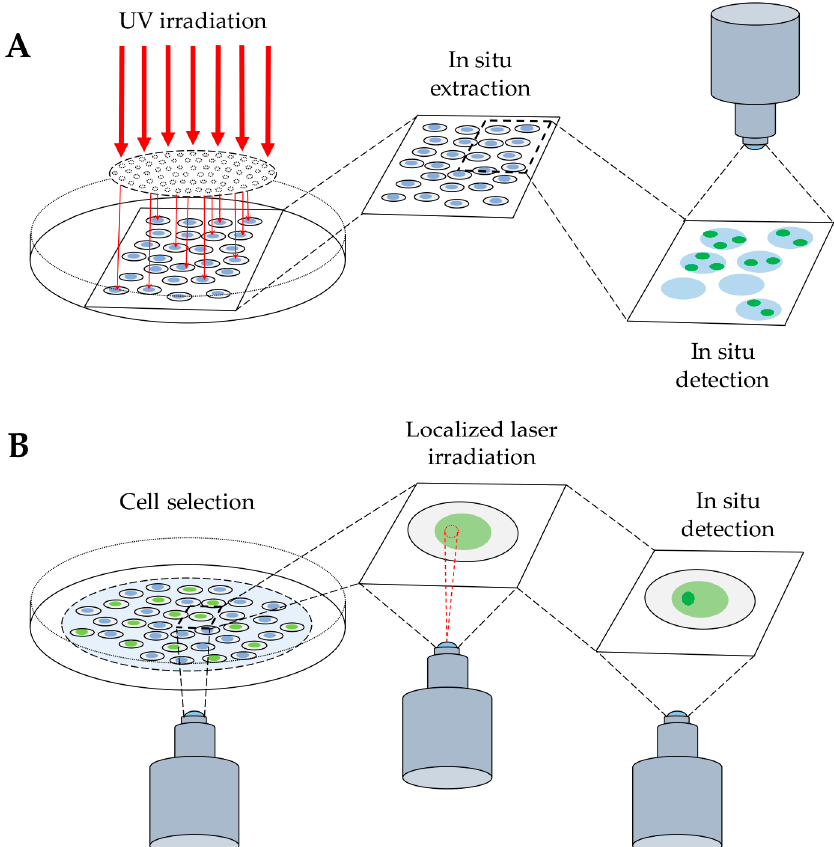
Figure 1. Detection of protein binding to DNA after radiation-induced DNA damage. ( A ) Schematic representation of cell exposure to UV radiation through a micropore polycarbonate filter to produce local DNA damage (see section 2.1.1). The next step of in situ extraction allows the release of unbound molecules, enabling the final detection of protein bound to DNA, by immunofluorescence technique. ( B ) Cell exposure to local laser irradiation to detect protein binding to DNA by indirect immunofluorescence method, as above, or by direct visualization of the accumulation of a fluorescently-tagged protein at the site of DNA damage in living cells (see section 2.2).